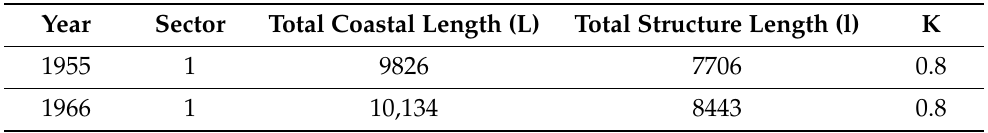
Table 2. The coefficient of coastal armouring K computed for each sector per year. The Total Coastal Length (L) and the Total Structure Length (l) per year are shown. All measures are expressed in metres (m). Sector no. 1 experienced significant increase, with K passing from “Maximal” (K = 1.2 in 1989) to the “Extreme” class (K = 1.6 in 2019). Sector no. 2 did not face any changes over the considered time span.